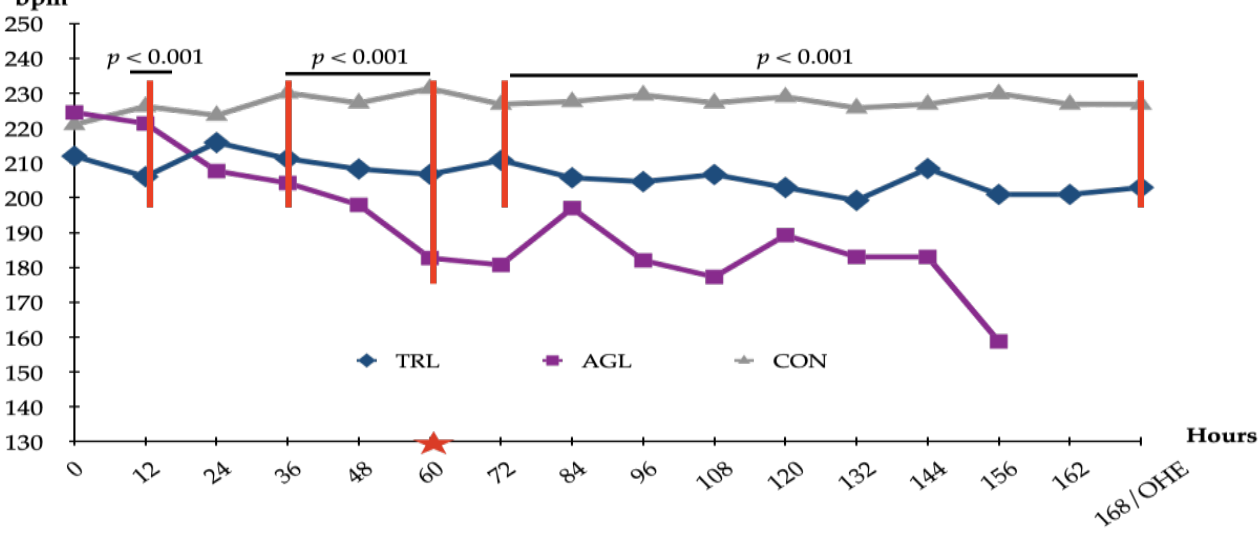
Figure 3. Fetal heart rate (FHR) for all study groups. TRL: trilostane; AGL: aglepristone; CON: control. The red star indicates the start of PT in the AGL group.